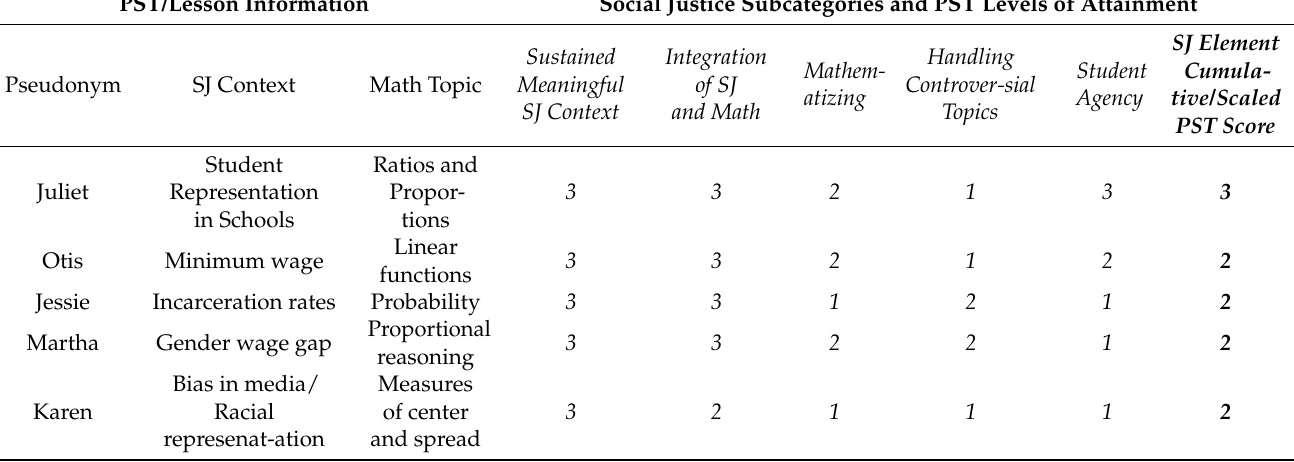
Table 3. Analysis